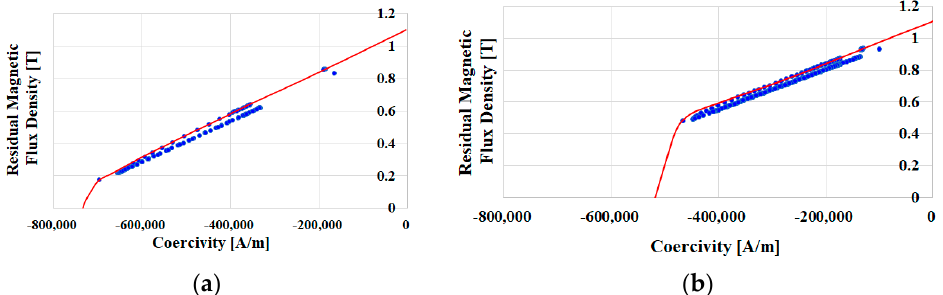
Figure 21. Operating points of the existing and proposed models: ( a ) NdFeB magnet B − H curve and operating point, ( b ) Dy − free magnet B-H curve and operating point.